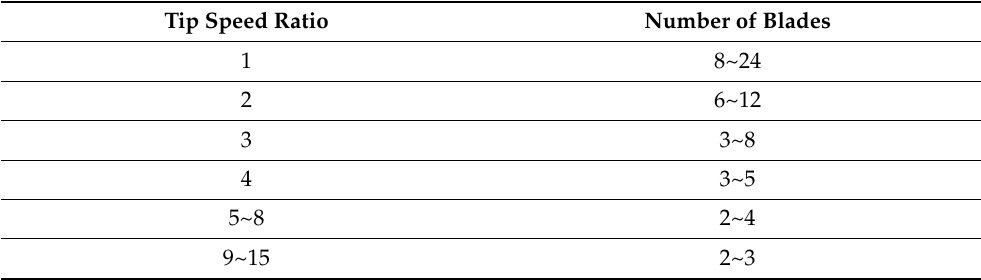
Table 1. Tip speed ratio and the matching number of blades